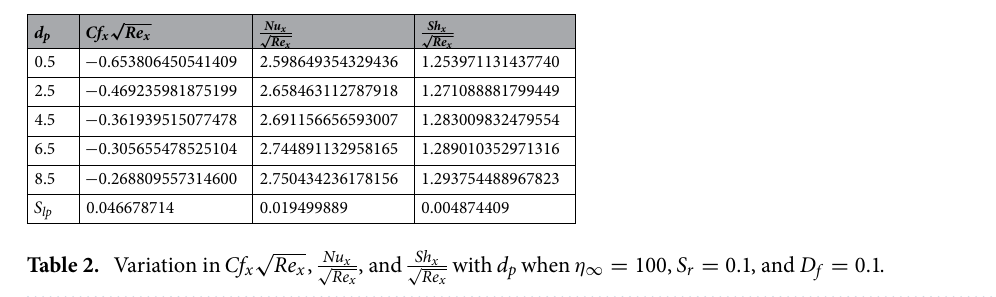
Table 2. Variation in Cf x √ Re x , Nu x